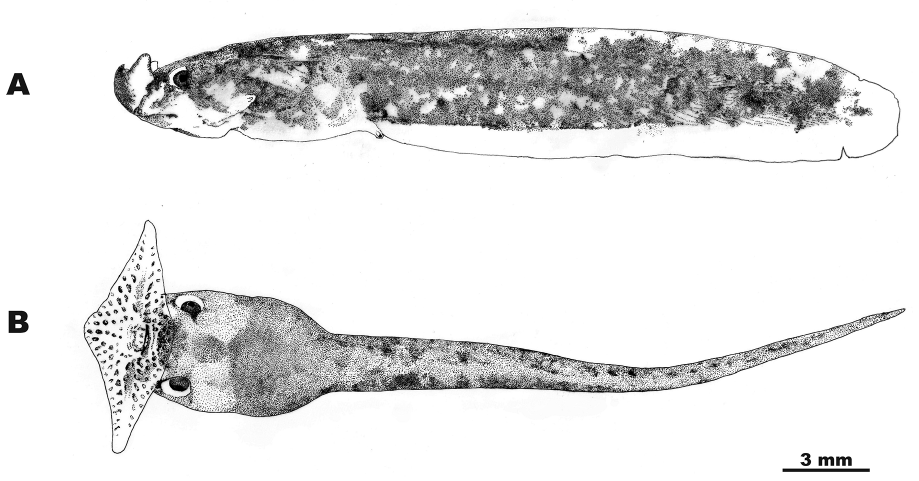
Figure 11. External morphology of the tadpole of Ophryophryne elfina sp. n. (ZMMU A-5679, field number NAP-01169; Stage 25, TOL = 30.2 mm). A lateral view, mouth funnel closed (in preservative) B dorsal view, mouth funnel open (in life). Drawings by V.D.